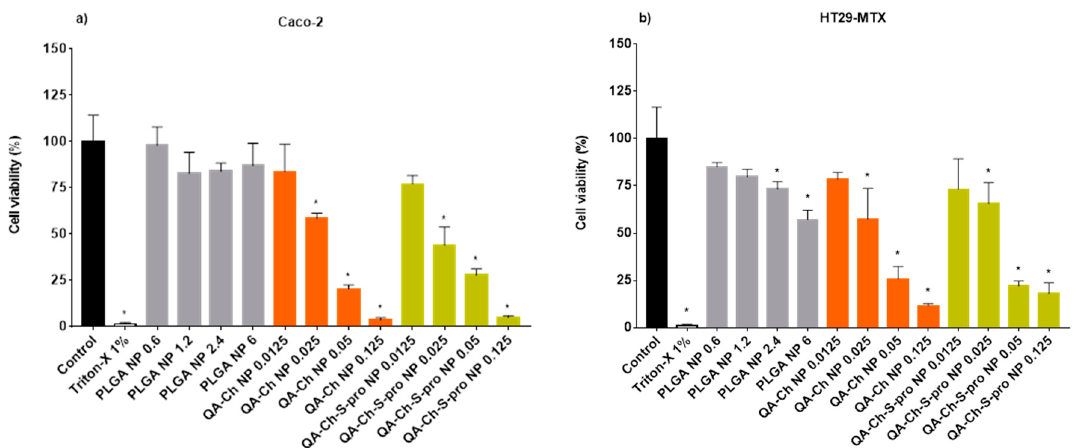
Figure 2. Caco-2 ( a ) and HT29-MTX ( b ) cell viability after 24-h treatment with empty PLGA NPs (0.6–6 mg PLGA/mL culture medium) or NPs from Ch derivatives (0.0125–0.125 mg QA-Ch or QA-Ch-S-pro/mL culture medium). Triton-X 1% was used as a negative control. *, significantly different from control (cells with medium).